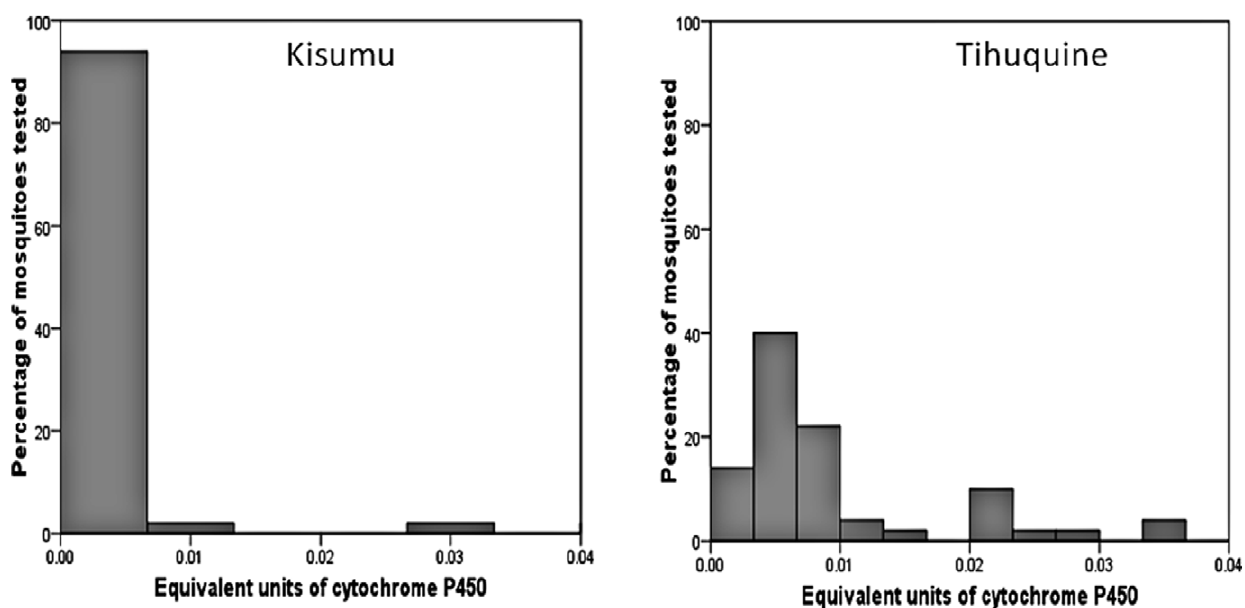
Figure 4. Monooxygenase activity. Estimated levels of cytochrome P450s (representing monooxygenase activity) in the An. funestus population of Tihuquine compared with An. gambiae Kisumu reference strain.